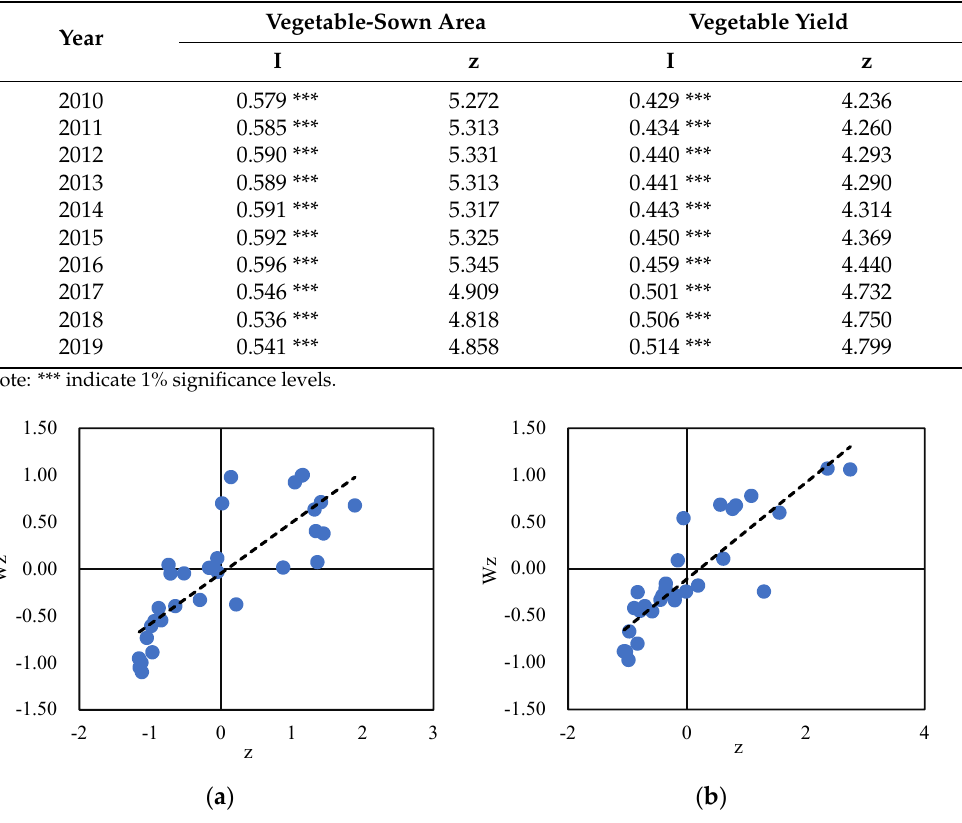
Figure 5. Moran scatter plot of vegetable planting area and yield: ( a ) 2019 vegetable-sown area; ( b ) 2019 vegetable yield.